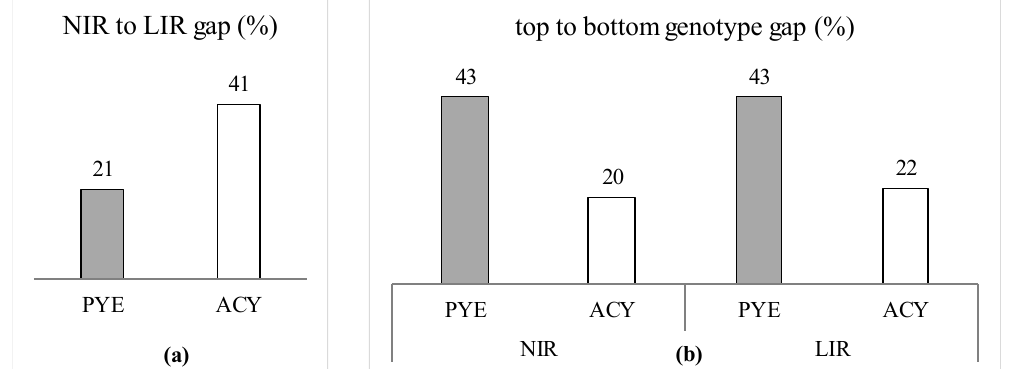
Figure 5. ( a ) The gap between NIR and LIR illustrates that the stress impact on overall yield was twice as high at dense stand (ACY) than at the ultra-low density (PYE). ( b ) The genotype di ff erentiation for yield was twice as high at the ultra-low density (PYE) rather than under dense stand